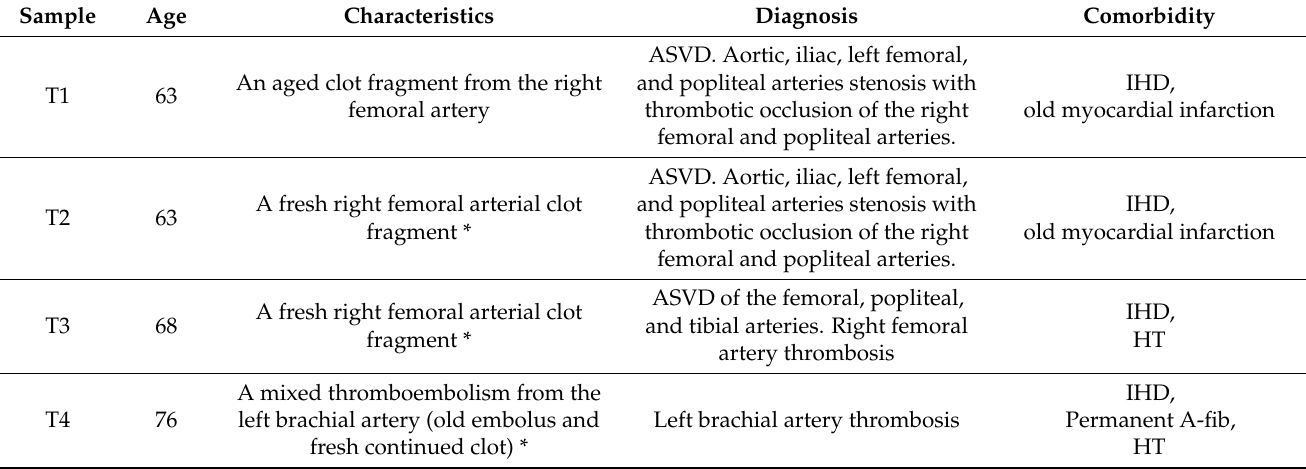
Table 1. Characterization of the extracted blood clots used in the